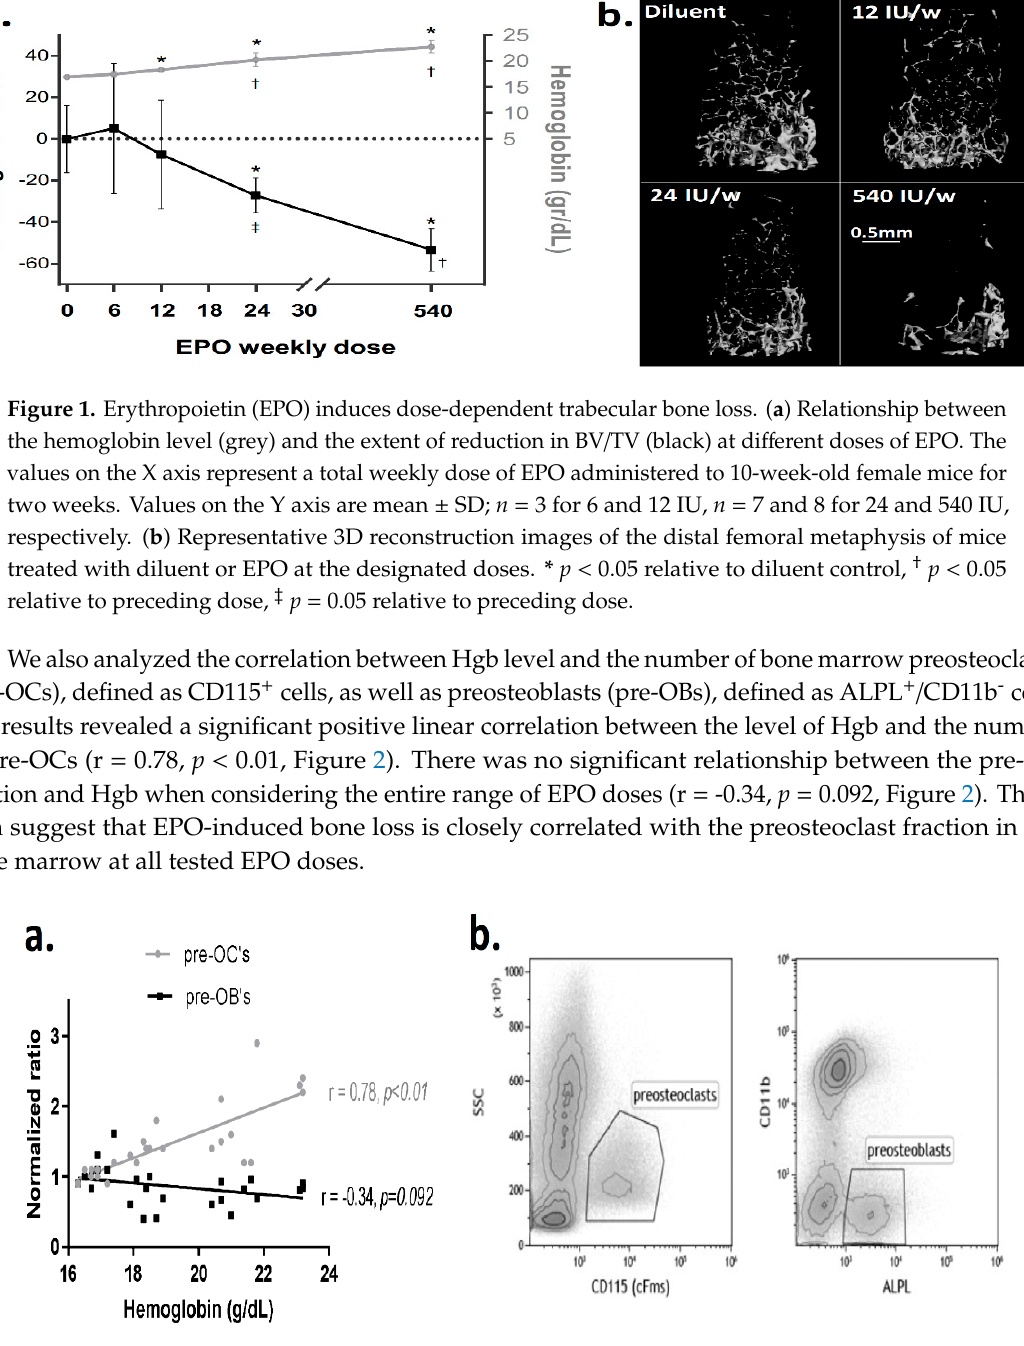
Figure 2. Administration of EPO is associated with a dose-dependent increase in the preosteoclast population. a. Linear correlation between the preosteoclast (pre-OCs, gray) and preosteoblast (pre-OBs, black) bone marrow populations versus hemoglobin level, following treatment with increasing doses of EPO as detailed in Figure 1. Values on the Y axis represent the normalized ratio of the corresponding population relative to the diluent control. Preosteoclasts were defined as CD115 (cFms) + whereas preosteoblasts as ALPL + / CD11b - cells in the bone marrow; b. Representative flow cytometry dot plots of the pre-OC (left) and pre-OB (right) populations of the EPO-treated animal (24IU / week). ALPL = alkaline phosphatase.